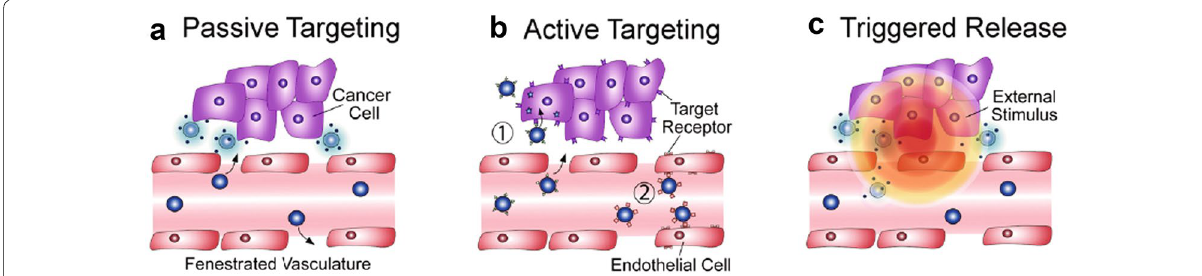
Fig. 2 Types of targeting for nanoparticle delivery to tumor tissue. a Passive targeting relies on the leaky vasculature that is exhibited by tumors, allowing nanoparticles to travel through the fenestrations and reach tumors. b Active targeting can be used when nanoparticles have ligands on their surface that can recognize and bind receptors that are overexpressed on tumor cells. c Triggered release allows nanoparticles to congregate if exposed to an external stimulus such as a magnetic field or light (Reproduced with permission from